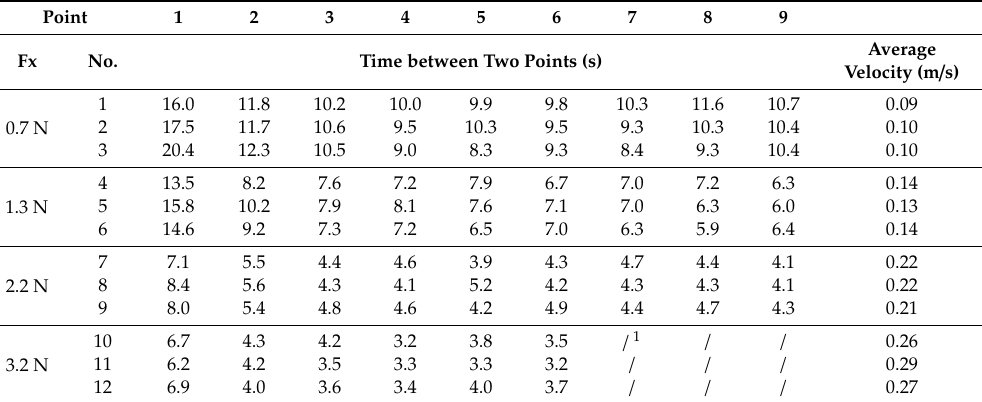
Table 2. Results of horizontal linear motion experiment.